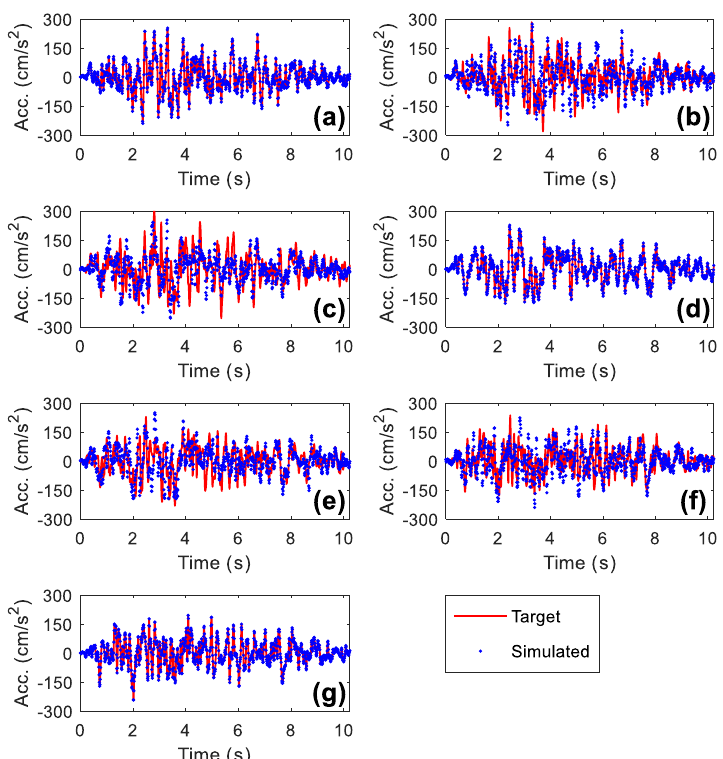
Fig. 2 Comparison between measured/target and simulated time histories at a site 1, b site 2, c site 3, d site 4, e site 5, f site 6, and g site